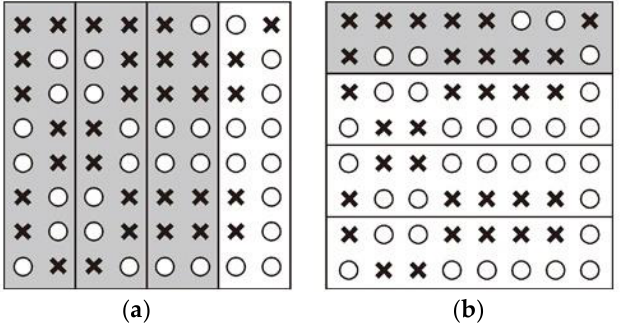
Figure 1. Impact of different districting in (a) vertical, or (b) horizontal. White circles and black crosses are independent basic voting units and represent the different party favors, respectively.